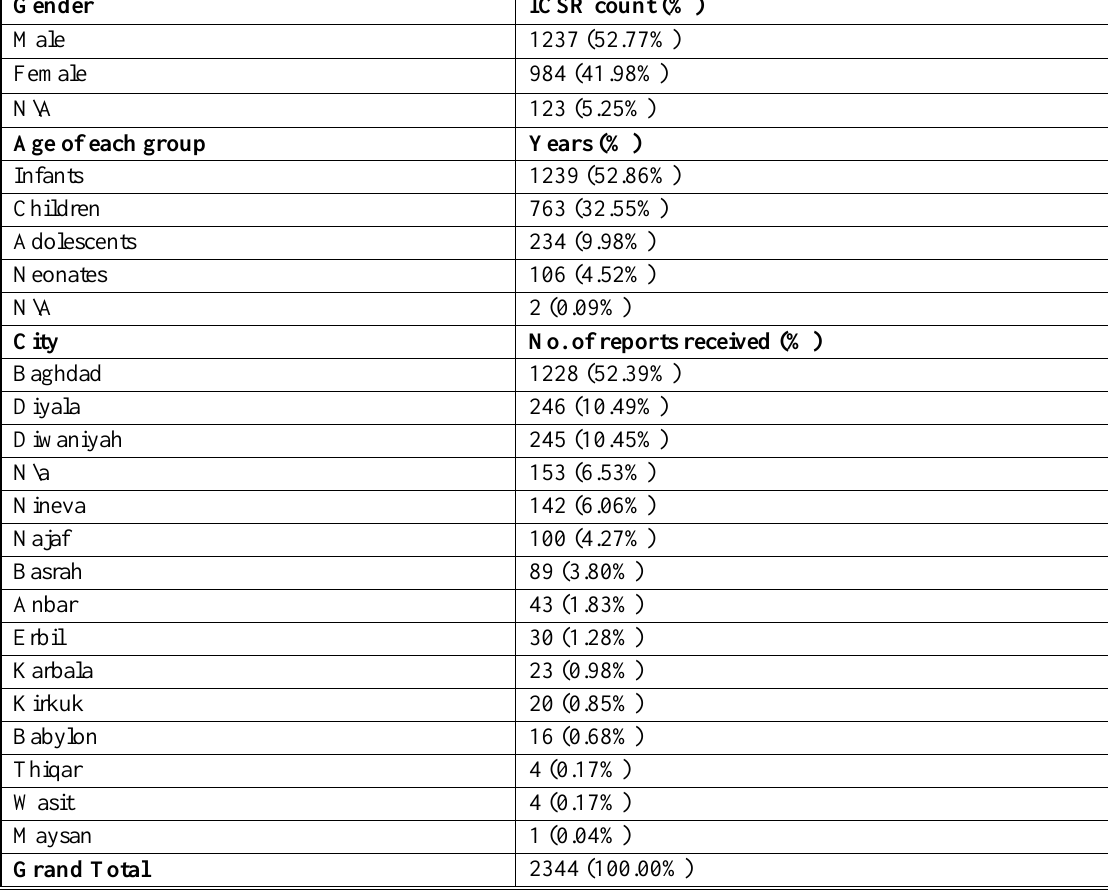
Figure 1. number of cases included and excluded in the study. Table 3. Demographic distribution of individual case safety